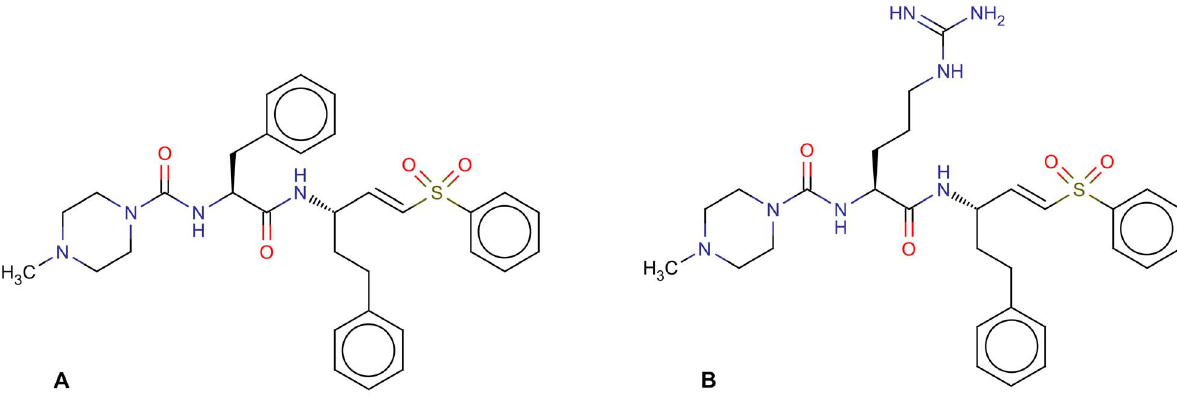
Figure 1. 2D structural representation of (A) K11777 and (B) WRR-483 inhibitors.